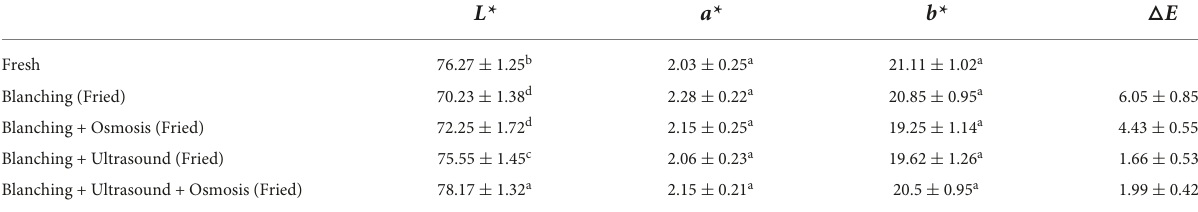
TABLE 2 The color analysis of Pleurotus eryngii